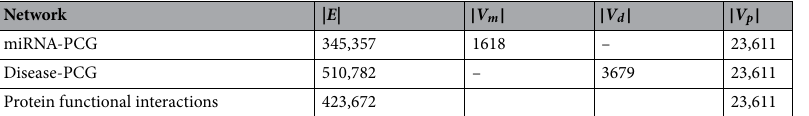
responding association between the PCG and the current disease if there exists one, and 0 otherwise.